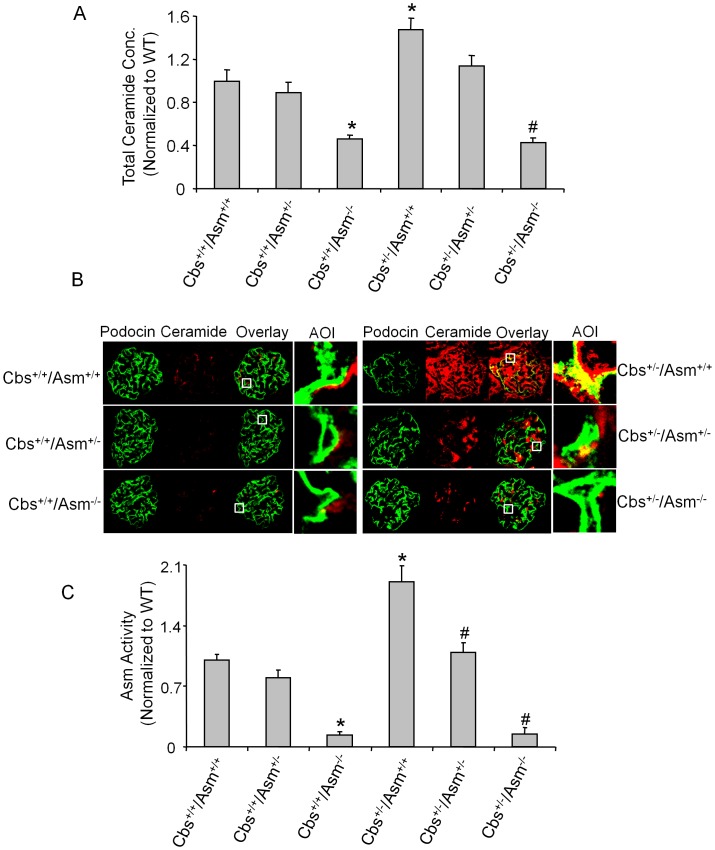
Renal tissue ceramide production and Asm activity in Cbs+/+/Asm+/+, Cbs+/+/Asm+/−, Cbs+/+/Asm−/−, Cbs+/−/Asm+/+, Cbs+/−/Asm+/− and Cbs+/−/Asm−/− mice.Values are arithmetic means ± SE (n = 6 each group) of total ceramide concentrations (A), ceramide production (B) and Asm activity (C) in Cbs+/+/Asm+/+, Cbs+/+/Asm+/−, Cbs+/+/Asm−/−, Cbs+/−/Asm+/+, Cbs+/−/Asm+/− and Cbs+/−/Asm−/− mice. The AOI shows the higher magnification of boxed area in overlaid images in panel B. AOI: Area of interest. * Significant difference (P<0.05) compared to the values from Cbs+/+/Asm+/+ mice; # Significant difference (P<0.05) compared to the values from Cbs+/−/Asm+/+ mice.